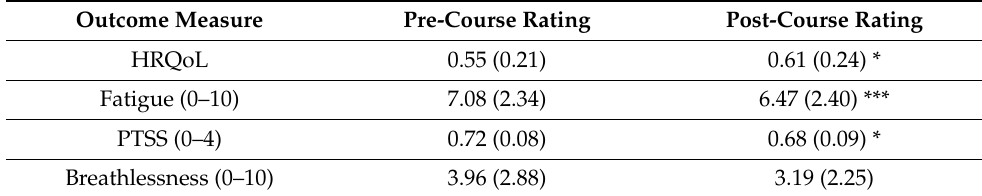
Table 2. Symptom ratings pre- and post-rehabilitation.